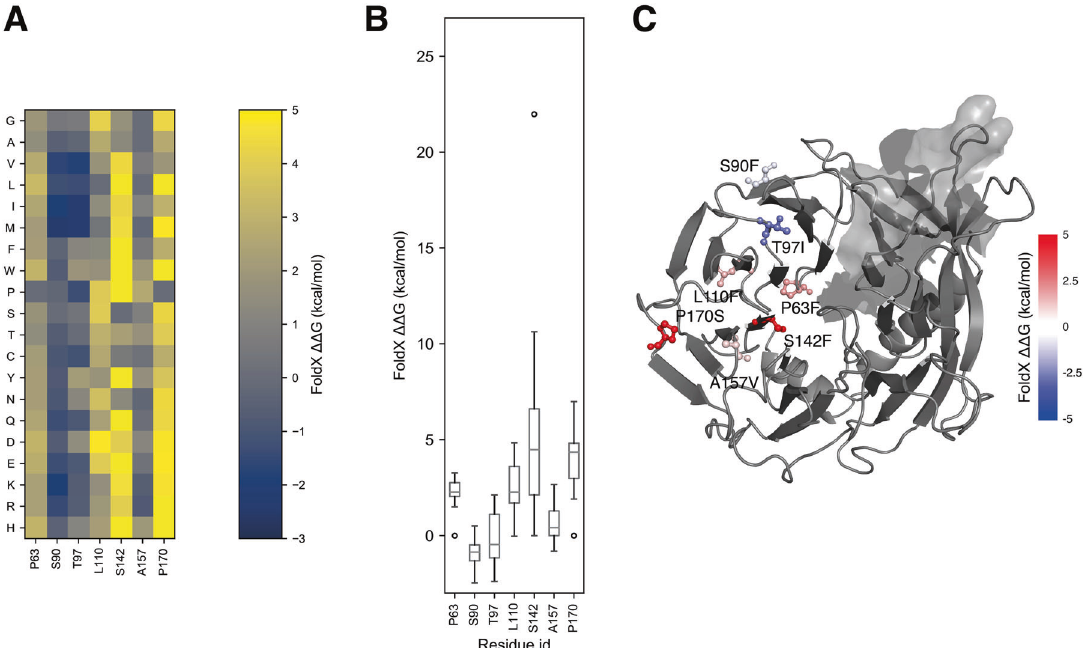
Fig. 6 Predicted changes of folding free energy upon mutation for the mutations experimentally tested. In these plots, positive values represent mutations predicted to be destabilizing the protein structure, while negative values represent mutations predicted to be stabilizing. A Heatmap with predicted changes of free energy for the whole mutational scans at the sites we tested experimentally. Values in the plot have been limited within the − 3 to 5 kcal/mol range to avoid using a less effective color scale due to outliers. B Box plots representing the distribution of the same values plotted in ( A ). C Residues at mutation sites corresponding to mutations that have been experimentally tested are shown on the predicted protein structure as sticks, colored proportionally to the predicted free energy change of the respective mutations, as per the colorbar. Values here have been limited in the − 5 to 5 kcal/mol for the same reasons as in ( B ) to obtain a symmetrical colormap around